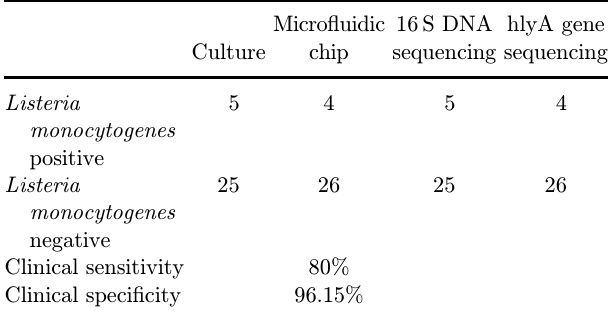
Table 2. Clinical sensitivity and speci¯city of the isothermal ampli¯cation assay on the micro°uidic